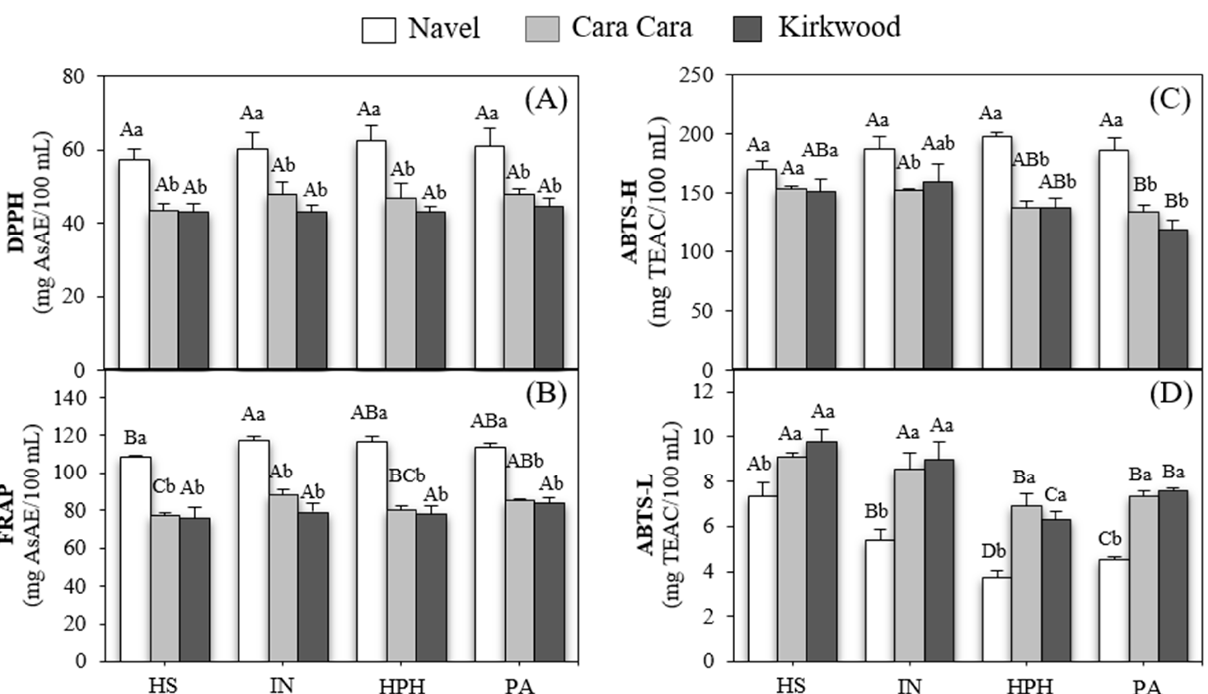
Figure 4. Hydrophilic antioxidant capacity assayed by DPPH ( A ), FRAP ( B ), and ABTS (ABTS-H) ( C ) and lipophilic antioxidant capacity assayed by ABTS (ABTS-L) ( D ) in hand-squeezed (HS), industrial (IN), HPH and pasteurized (PA) juices of N, CC and K orange. Uppercase letters indicate significant differences between different type of juices for the same variety, and lowercase letters indicate significant differences between varieties for the same type of juice one-way ANOVA ( p < 0.05).